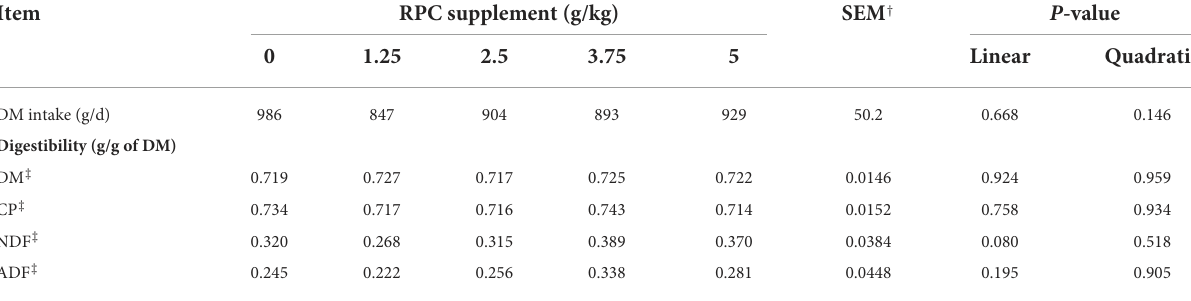
TABLE 3 Intake and total tract apparent nutrient digestibility of fattening lambs fed experimental diets supplemented with nil (CON) or rumen-protected choline (RPC) ( n = 6 per